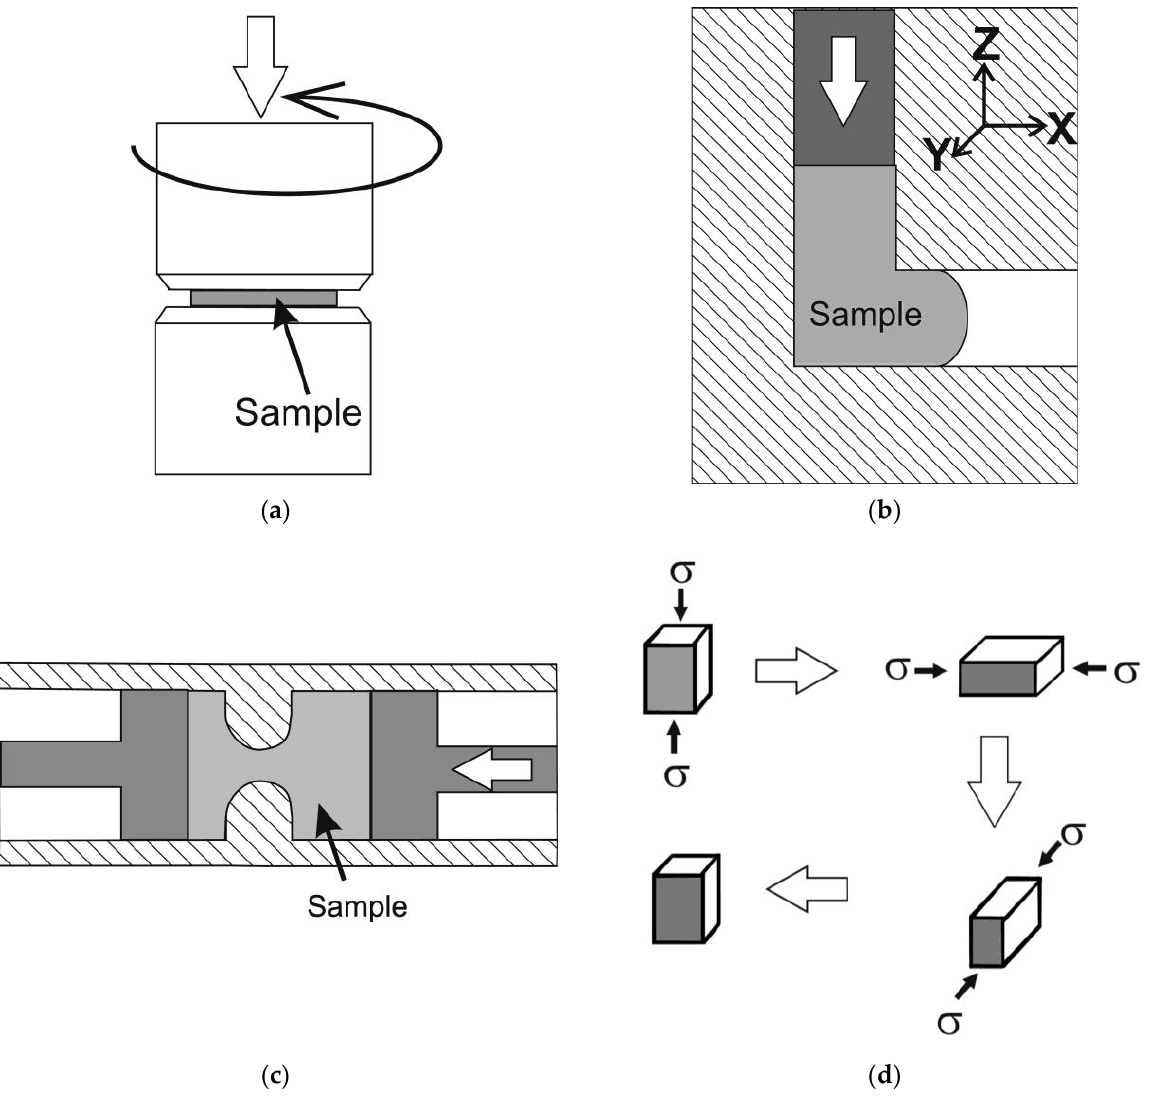
Figure 1 . Large strain deformation by high-pressure torsion (HPT) ( a ), equal-channel angular pressing (ECAP) ( b ), reciprocating extrusion ( c ), and multiple multidirectional forging ( d ).